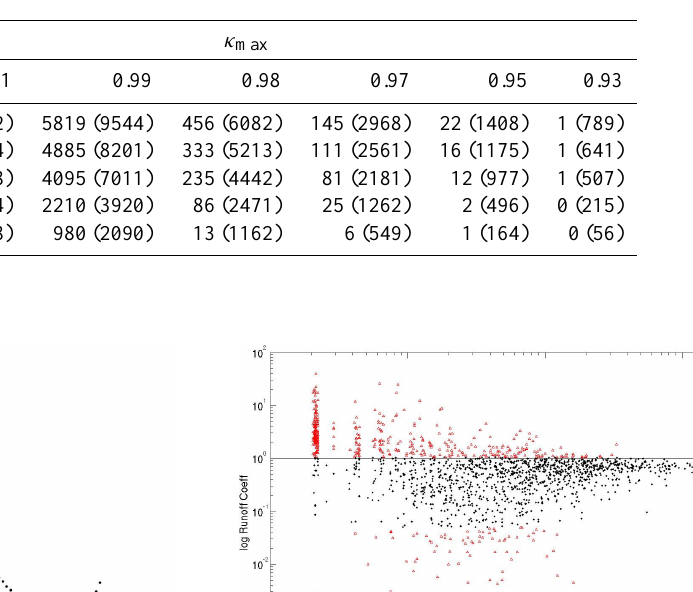
Table 1. Table showing the number of Monte Carlo samples considered behavioural for varying thresholds. Values for the data series with disinformative periods removed are shown in brackets.